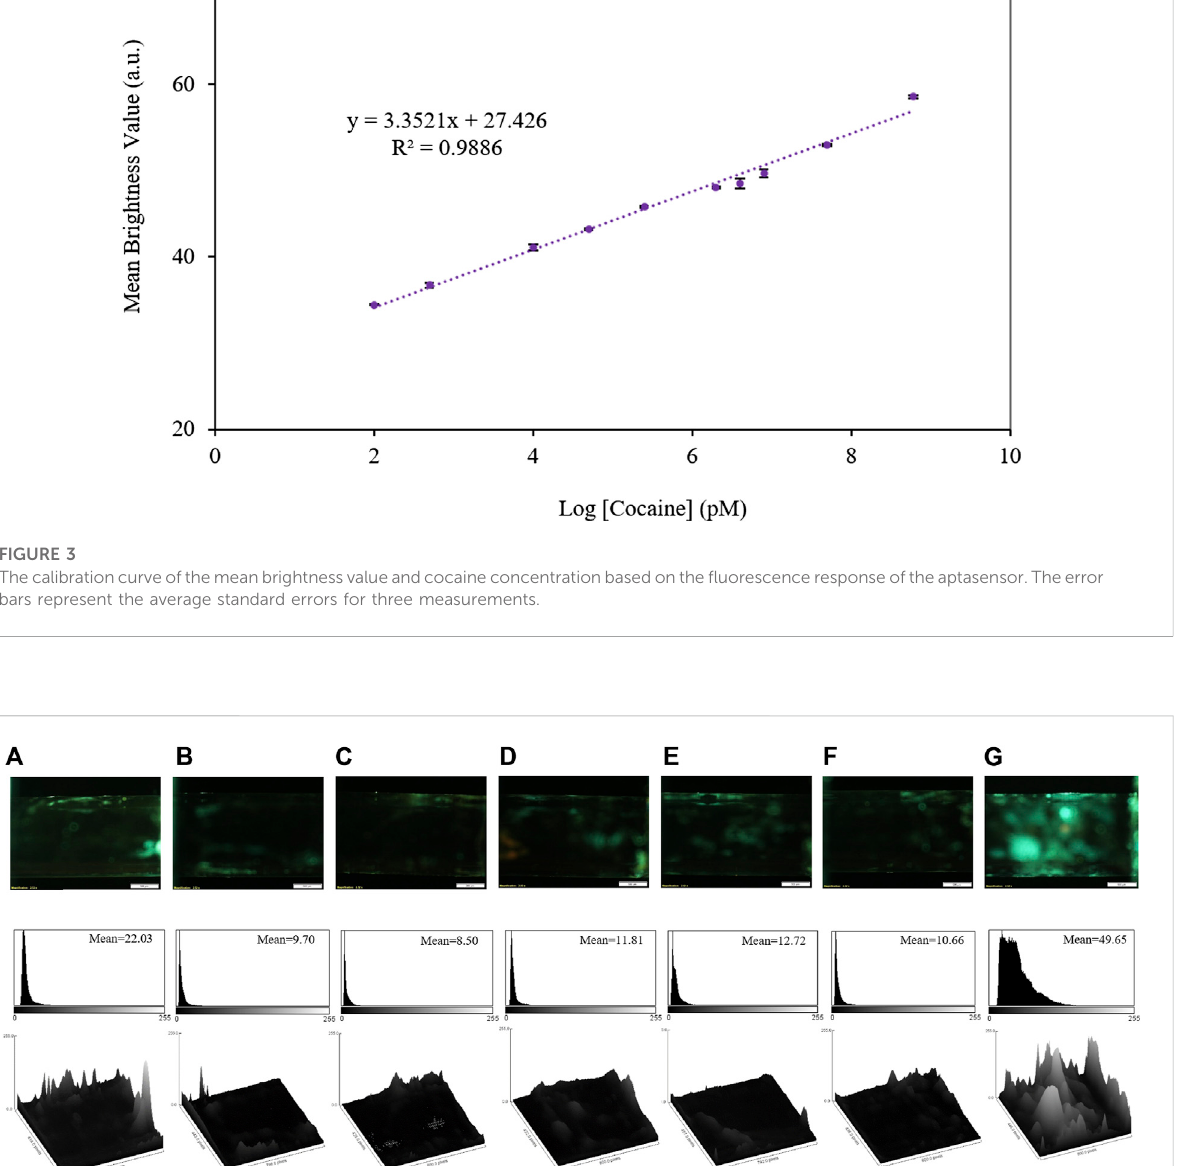
response of the aptasensor, because of non-speci fi c af fi nity for the aptamer binding. Hence, the sensitive aptasensing platform possessed a superior selectivity toward cocaine.